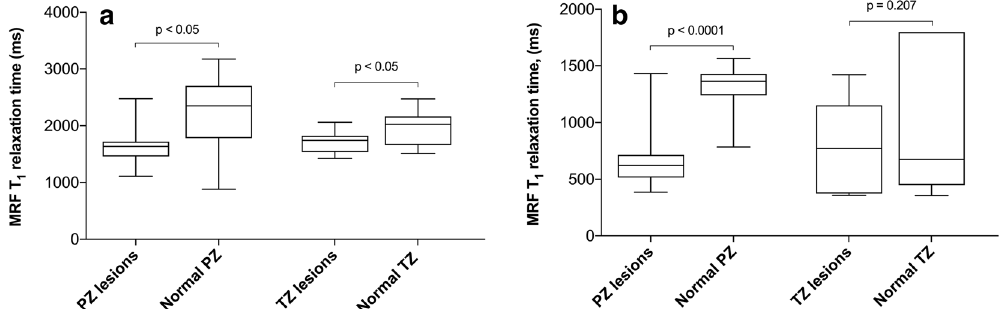
Figure 4. Box-and-whisker plots comparing MRF T 1 relaxation times obtained from prostate lesions and corresponding normal PZ and TZ before ( a ) and after ( b ) gadolinium-based contrast agent administration. Top and bottom of boxes represent 25th and 75th percentiles of data, respectively; line in boxes represents the median value and bars represent minimum and maximum values. MRF magnetic resonance fingerprinting, PZ peripheral zone, TZ transition zone.